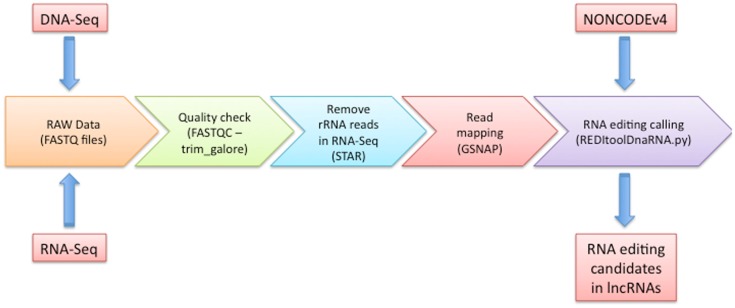
Graphical overview of our computational methodology. In this figure, we show all steps that should be followed to predict potential RNA editing sites in human lncRNA transcripts. Details are discussed in the main text.